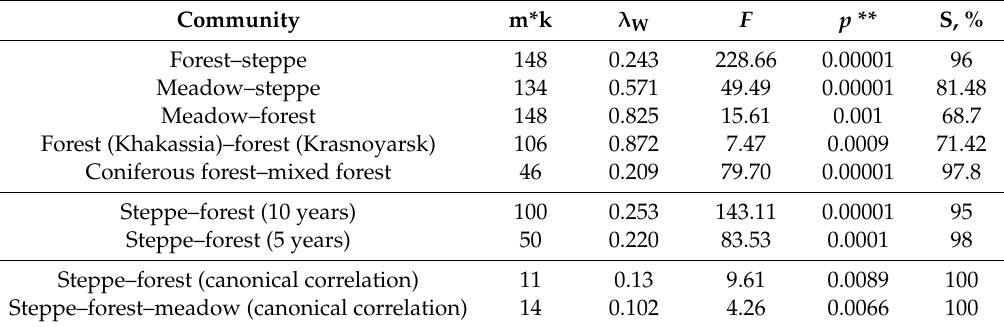
Figure 4. Characterization of the NDVIF seasonal curves in the (NDVIF max , dNDVIF / dn) plane for the steppe ( 1 ) and forest ( 2 ) communities in Khakassia. Table 3. Parameters of discriminant analysis for plant communities *.